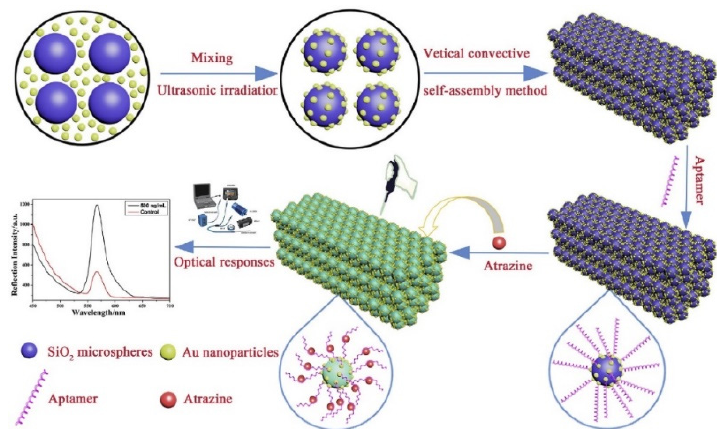
Figure 7. Scheme of preparation photonic crystal-based sensor for atrazine detection. Republished with permission from [93]; permission conveyed through Copyright Clearance Center, Inc.